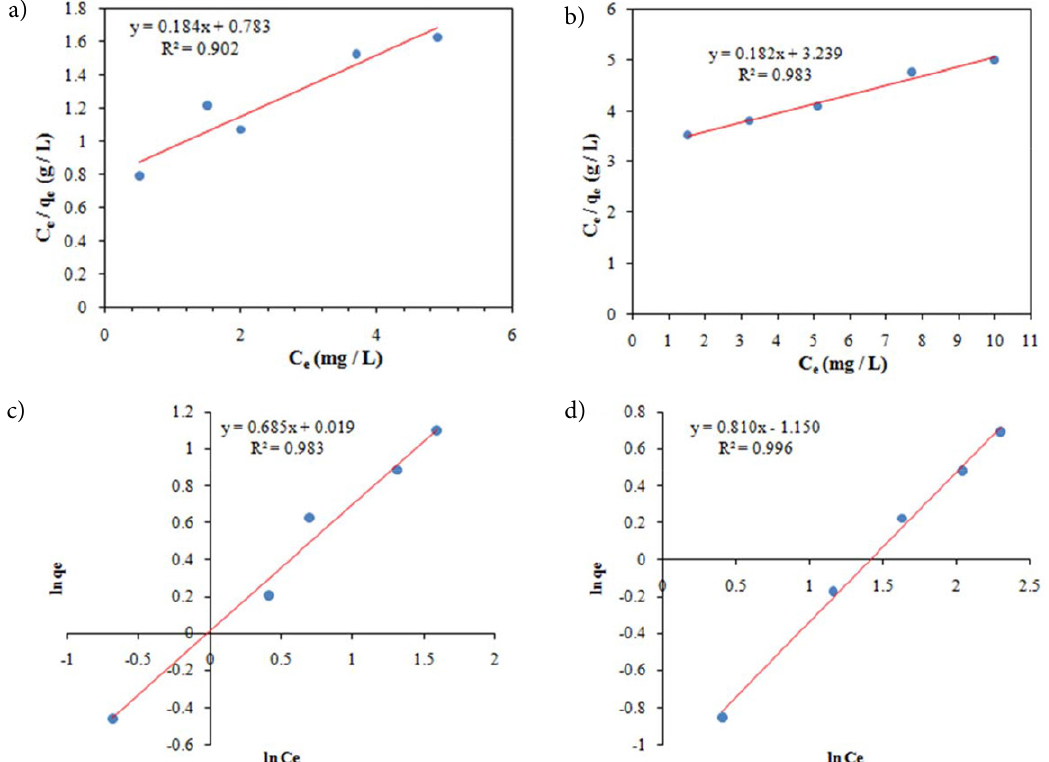
Figure 2. (a &b) Langmuir isotherms and (c & d) Freundlich isotherm for the adsorbents SPU and